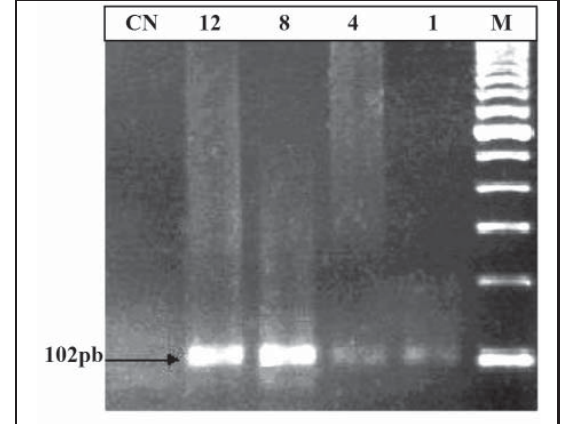
Figura 3 – Gel de agarose a 2% da amostra 11FT mostrando resultado da nested-PCR para o éxon 8 do gene TP53 com diferentes volumes de amplifi cado da primeira